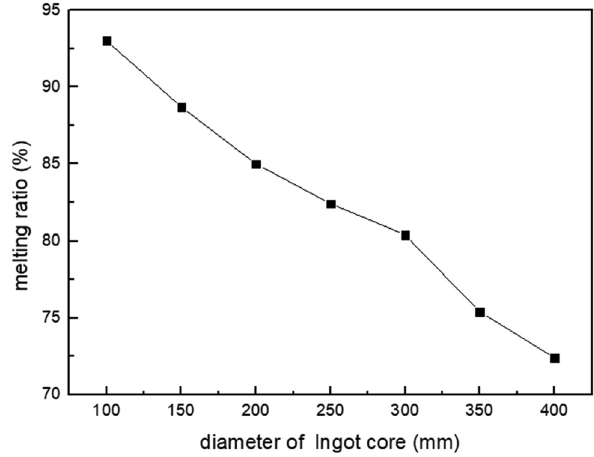
Figure 7: Interfacial melting rate between ingot core and cladding